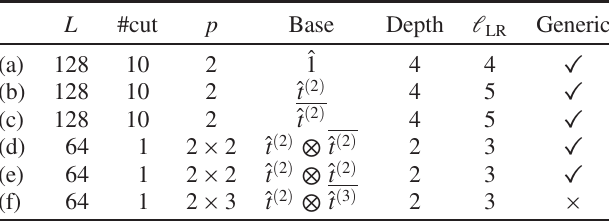
HOI CHUN PO et TABLE I. Settings for the MPU used in Fig. 11. L denotes the total length of the ring used in the computation, and “ #cut ” denotes the number of cuts at which the chiral unitary index was computed. Here, p denotes the dimension of the site Hilbert space; “ base ” and “ depth, ” respectively, denote the choice in the “ base MPU ” and the depth of the FDLU, as illustrated in Fig. 11; and l indicates the Lieb-Robinson length of the MPU. LR “ Generic ” indicates whether or not fully generic two-site MPUs are used in the FDLU.